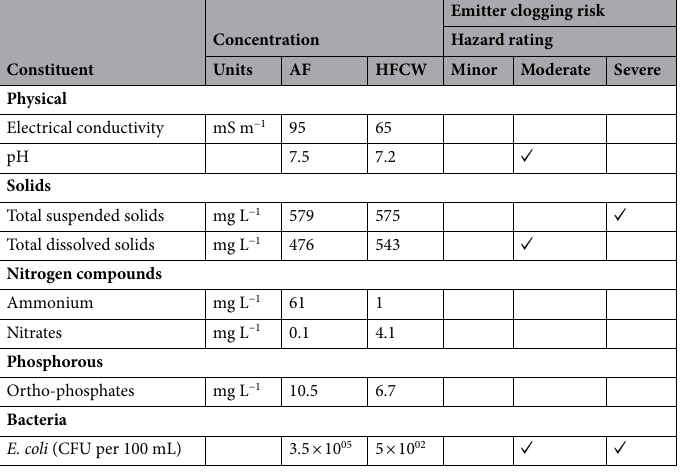
Table 2. DEWATS effluent quality characterisation and the corresponding emitter clogging risks 42 . CFU colony forming